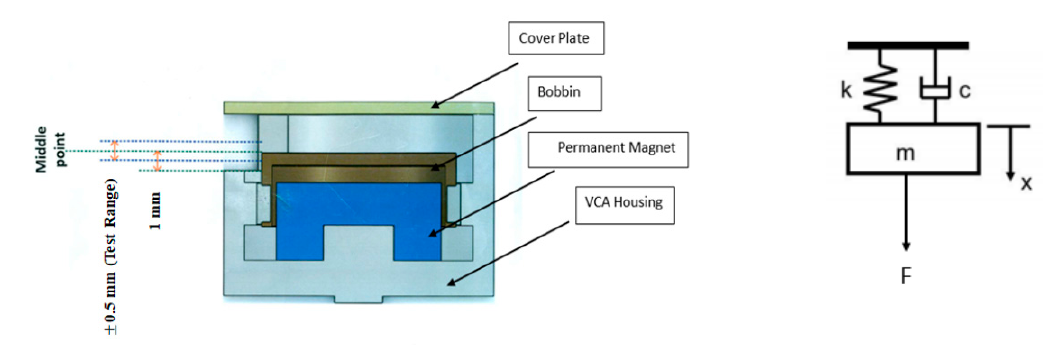
Figure 5. Physical and mass-spring-damper system. Table 1. Physical and geometrical properties of the beam.